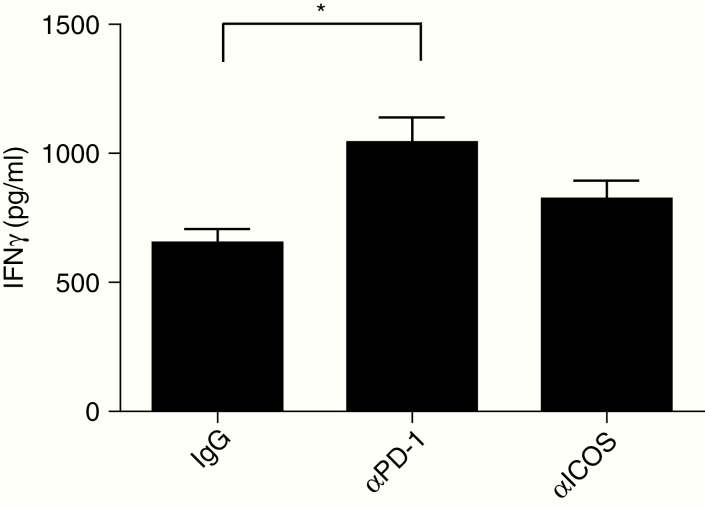
Splenocytes from glioma-bearing mice treated with Delta24-RGD produce significantly more IFNγ when cultured with PD-1 blockade. Splenocytes were harvested, processed into single cells, and co-cultured with GL261 cells with hamster IgG (IgG control), anti-PD-1 blocking antibody, or anti-ICOS agonist antibody. After 4 days, the supernatant was collected and IFNγ production was assessed using ELISA. Splenocytes from Delta24-RGD-treated mice produce IFNγ upon recognition of GL261 glioma cells (IgG bar). IFNγ production was significantly increased with anti-PD-1 blocking antibodies but not with ICOS agonist antibodies (P = .0029). P-value is calculated by ANOVA and corrected for multiple testing with the post-hoc Bonferroni test. *P < .05.